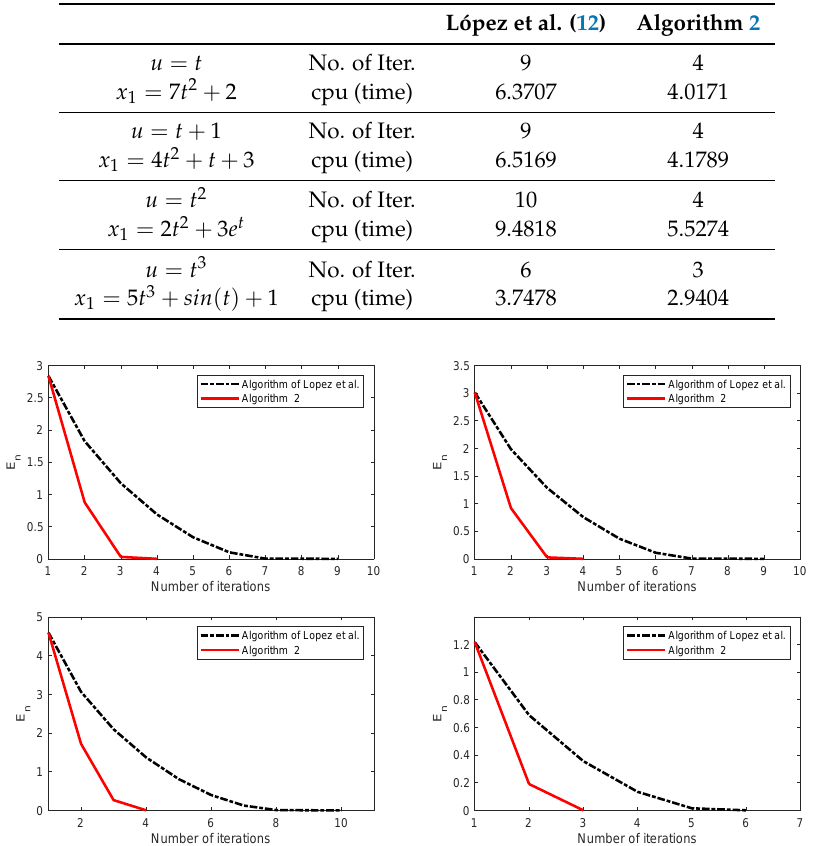
Figure 5. Error versus numberof iterations of Algorithm 2 in L 2